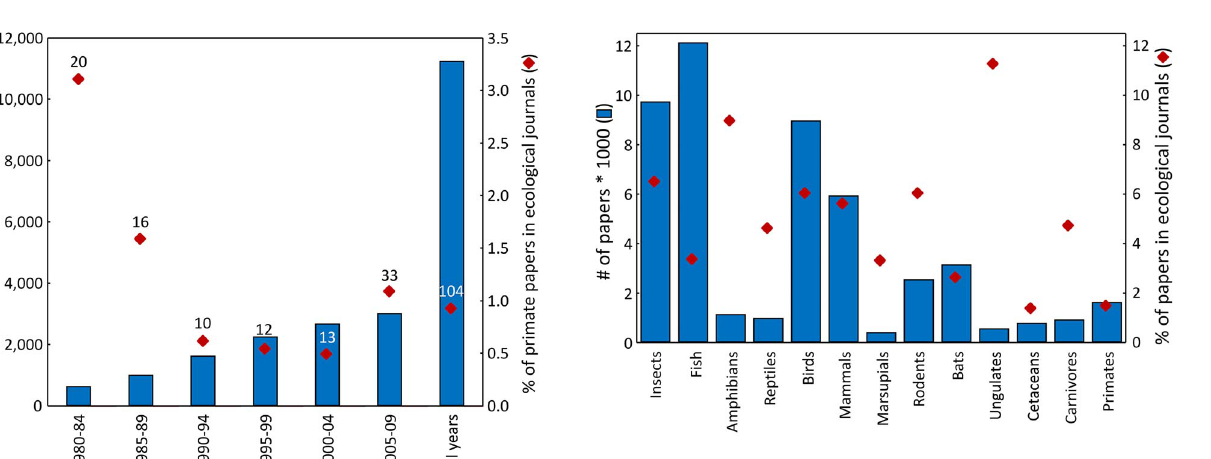
Figure 4. Number of papers on the ecology of insects, different classes of vertebrates and major orders of mammals, and the percentage of these papers that are published in high-ranking ecological